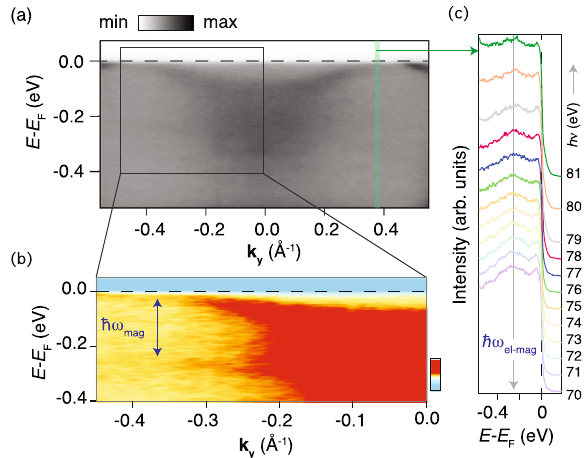
Fig. 4 Magnonic polarons. a Measured γ -band dispersion for the sample with strongest electron – magnon coupling (S4, same data of Fig. 3a) but with modi fi ed contrast. The γ band is strongly renormalised, with the coherent quasiparticle band having an occupied bandwidth of only ≈ 100 meV (measurement taken at h ν = 80 eV). b A replica of this band is evident, shifted to higher binding energies by the characteristic magnon energy of ≈ 240 meV, indicative of polaron formation. c Energy distribution curves taken at the momentum value indicated by the green line in ( a ) show how this replica band feature is independent of photon energy, pointing to a strong intrinsic electron – magnon coupling